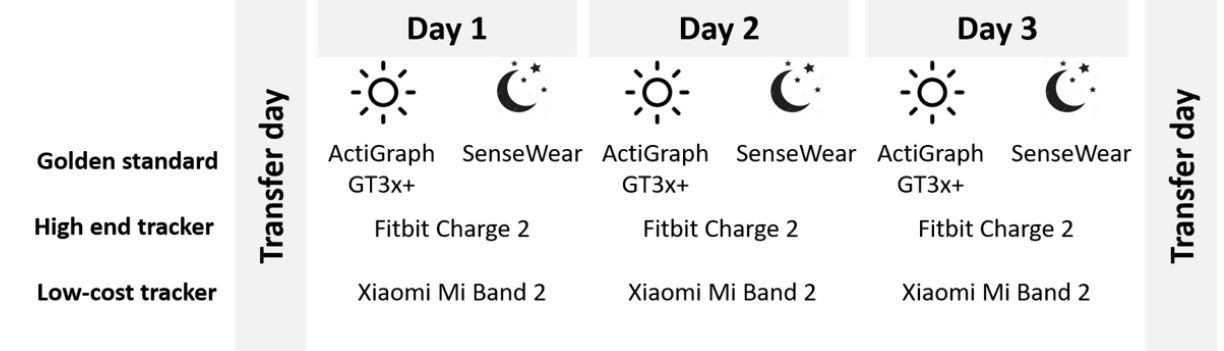
Figure 2. An example of the measurement protocol for one